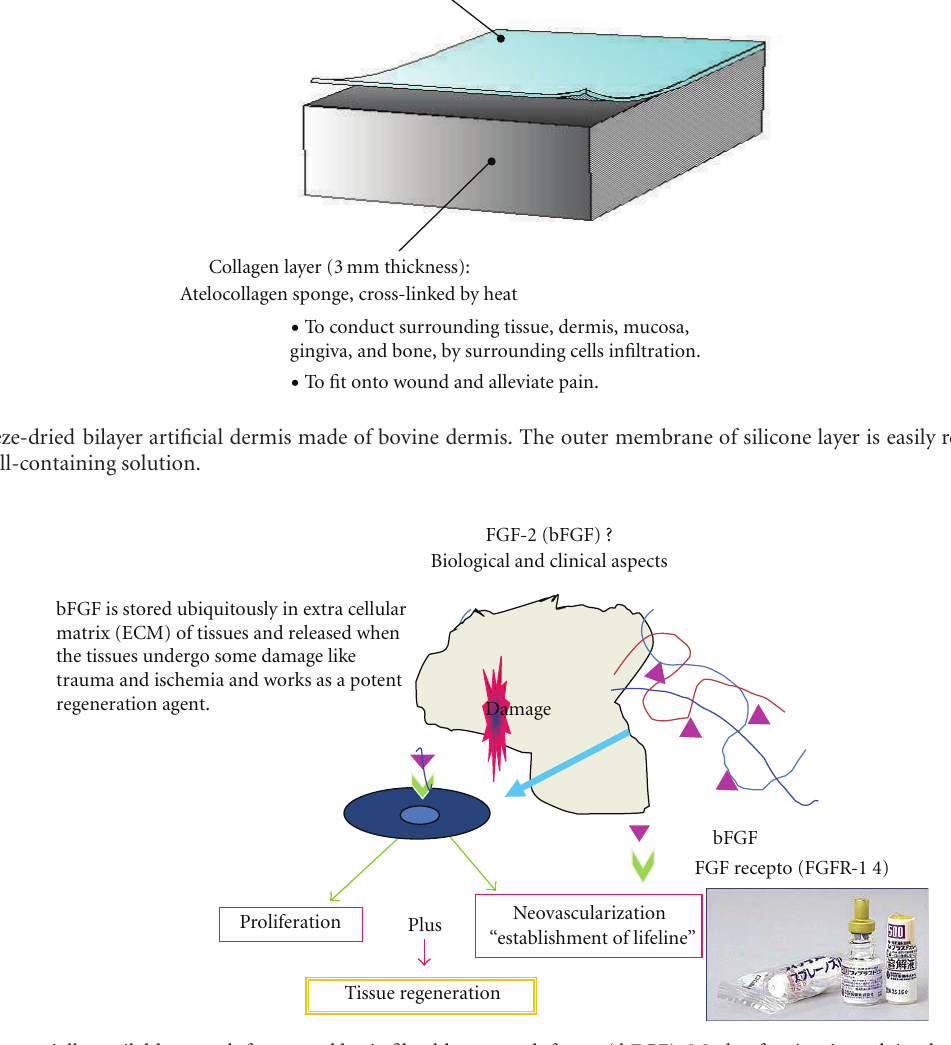
Figure 4: Commercially available growth factor and basic fibroblast growth factor ( bFGF). Mode of action is explained and the mechanism is